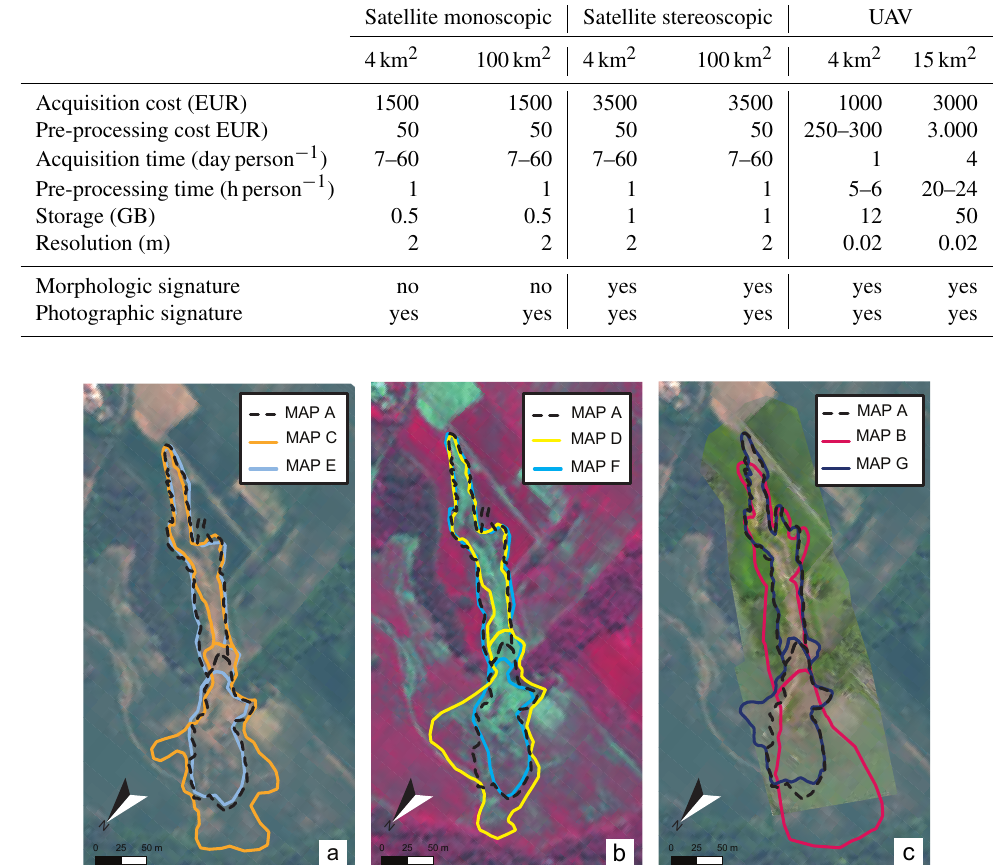
Figure 7. Comparison of landslide maps prepared for the Assignano landslide, Umbria, central Italy. (a) Landslide map obtained from a monoscopic (Map C, dark yellow line) and a stereoscopic (Map E, light blue line), true-colour (TC) WorldView-2 satellite image (base image), and a mapping of the landslide obtained by walking a GPS receiver along the landslide boundary (Map A, black line). (b) Landslide map obtained from a monoscopic (Map D, yellow line) and a stereoscopic (Map F, cyan line), false-colour-composite (FCC) WorldView- 2 satellite image, and a mapping obtained by walking a GPS receiver along the landslide boundary (Map A, black line). (c) Landslide map obtained from field survey (Map B, pink line) and from a monoscopic, TC, ultra-high-resolution image captured by a UAV (Map G, purple line), and the mapping obtained by walking a GPS receiver along the landslide boundary (Map A, black